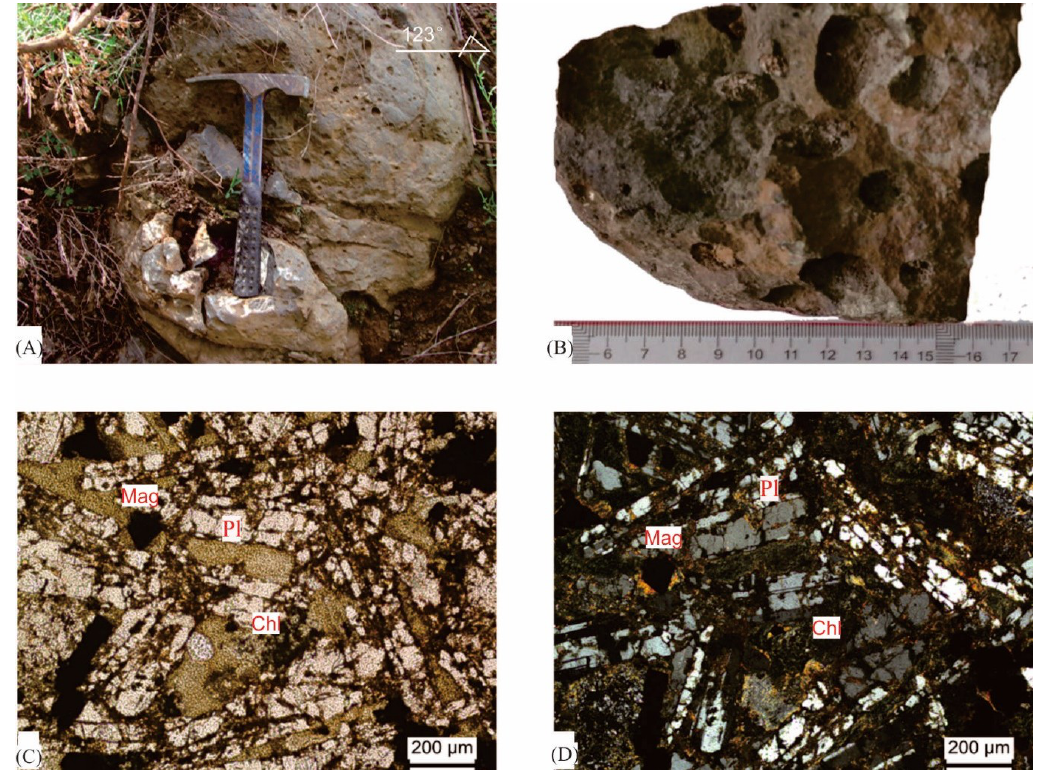
Figure 4 Figure 4. Field and thin-section petrographic photos of the Yinmin Formation spilite, showing ( A ) massive structure; ( B ) amygdaloidal texture; ( C ) spilite texture (plane polar); and ( D ) spilite texture (crossed polar). Abbreviations: Pl = Plagioclase; Mag = Magnetite; Chl =